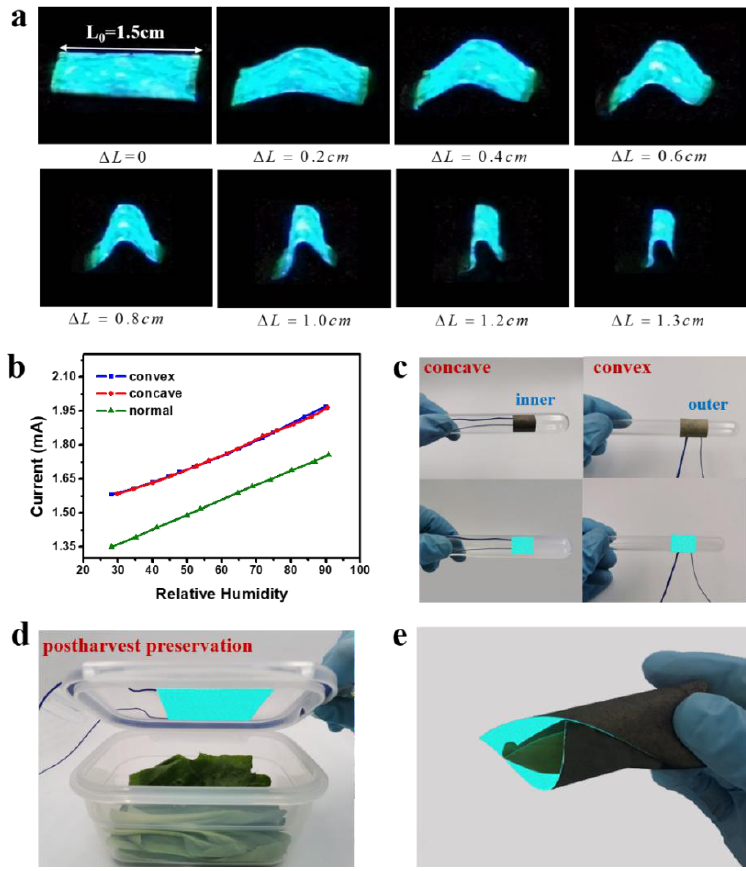
Figure 6. ( a ) Measurements for the bending performance of the ACELs. ( b ) Linear fitting curve of Figure6. ( a )MeasurementsforthebendingperformanceoftheACELs. ( b )Linearfittingcurveofcurrent current and humidity from 26% to 90% under different conditions. ( c ) Images of the paper-based and humidity from 26% to 90% under di ff erent conditions. ( c ) Images of the paper-based ACELs working ACELs working under different bending conditions. ( d , e ) Images of the device working for under di ff erent bending conditions. ( d , e ) Images of the device working for postharvest postharvest preservation.